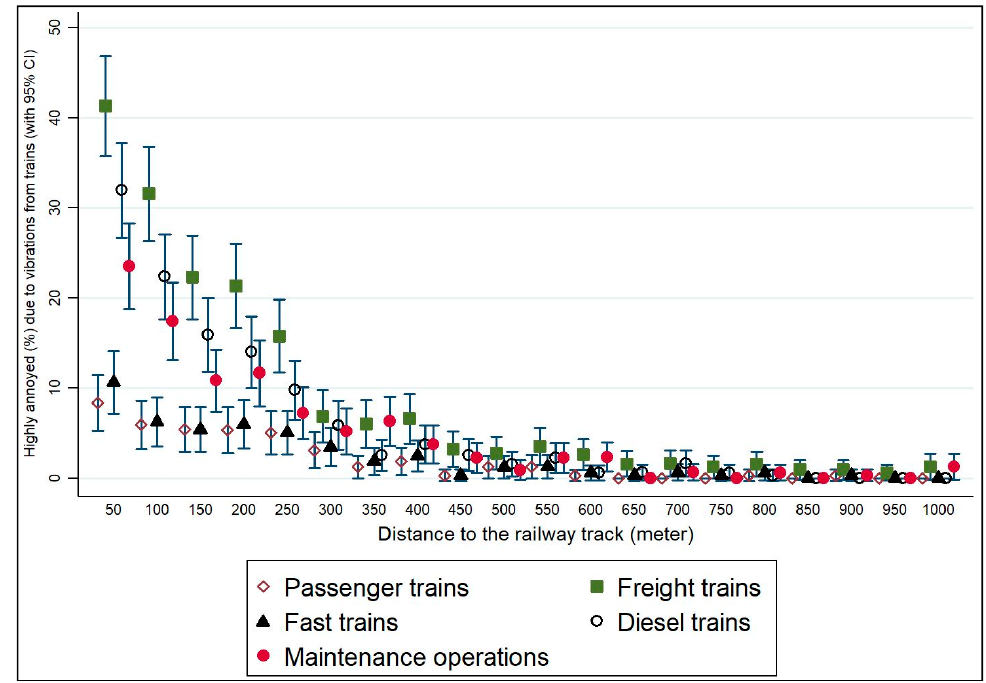
Figure 3. The association between distance from the railway track and high annoyance due to vibrations from trains.